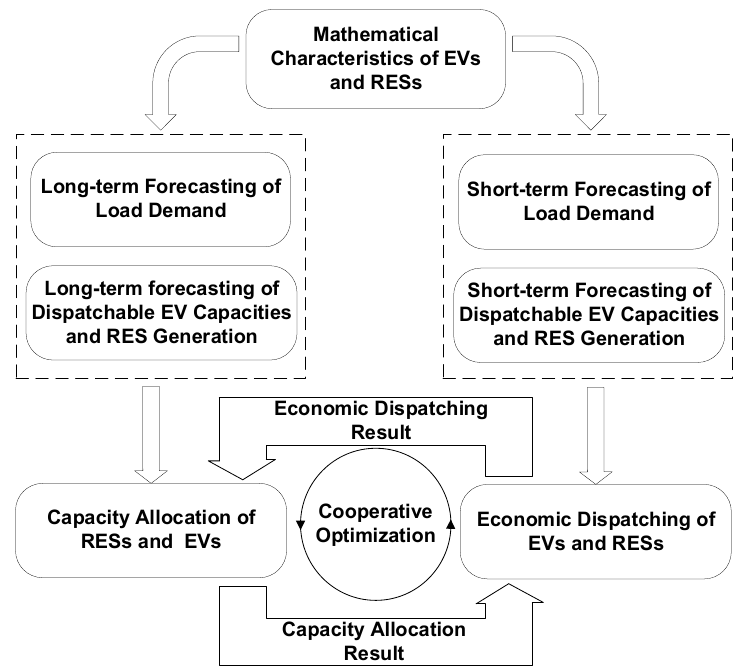
Figure 1. Brief process of cooperative optimization of EVs (Electric Vehicles) and RESs (Renewable Energy Sources).